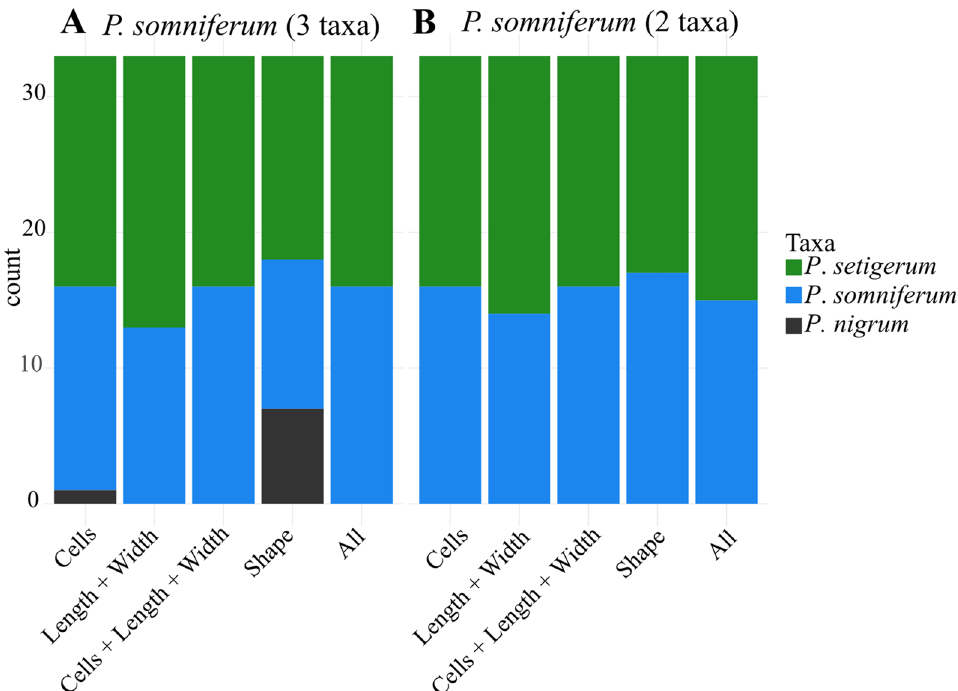
Figure 6. Assignation of the 33 archaeological seeds: Benchmarking of linear discriminant analyses on (A) three taxa ( P. setigerum , P. somniferum and P. nigrum ) and (B) two taxa ( P. setigerum , P. somniferum ) using different variables or set of